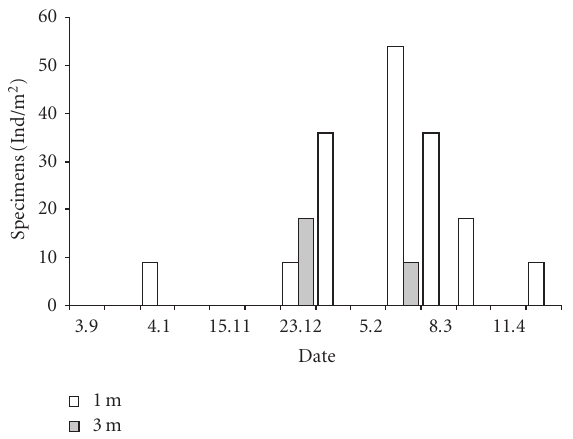
Figure 7: Abundance of Thoracophorus guadalupensis on forest floor during the dry period in the Varzea forest of Ilha de Curari at sites inundated 1 or 3 m during immersion period. No specimens were found at 4 m and 5m immersed